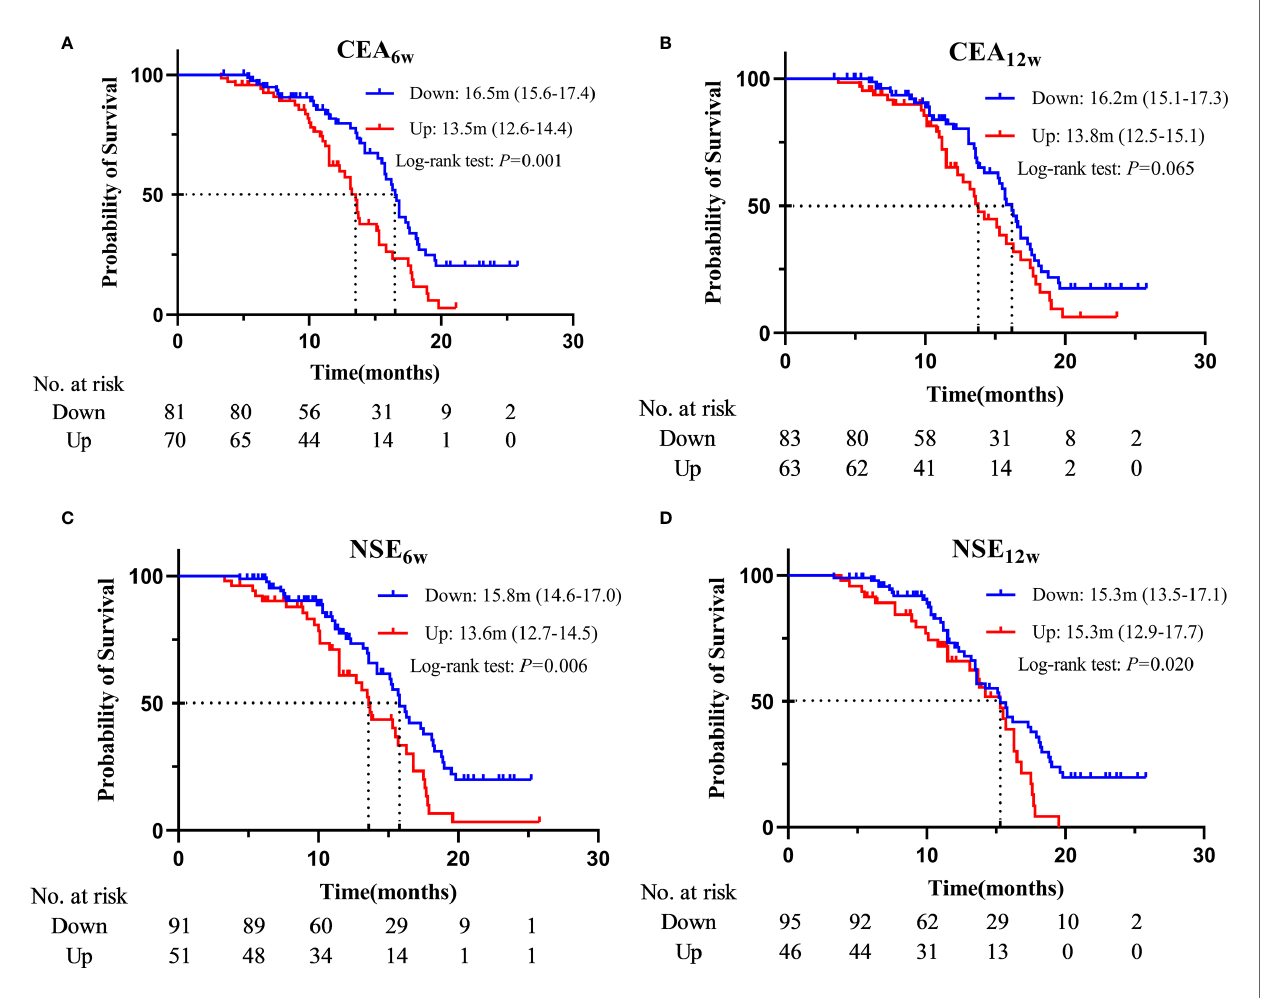
FIGURE 3 | Kaplan – Meier curves for OS according to CEA 6w (A) , CEA 12w (B) , NSE 6w (C) and NSE 12w (D)